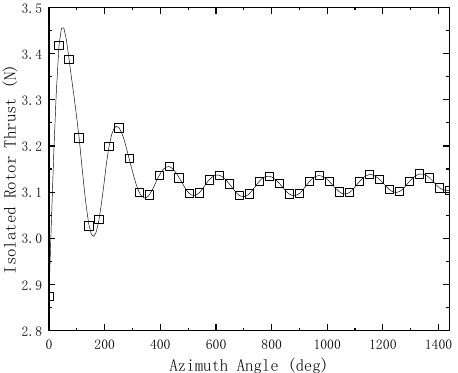
Figure 6. Thrust variation of the isolated rotor.